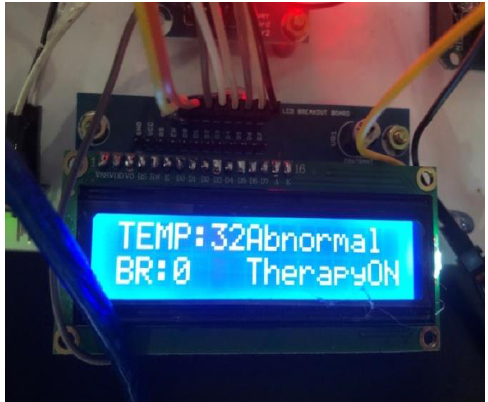
Fig 6: LCD display when the condition is abnormal